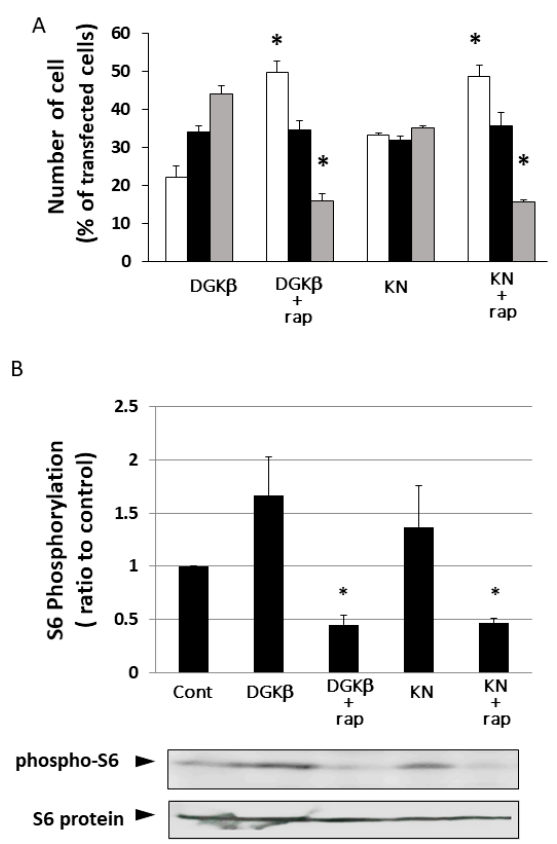
Figure 6. Involvement of mTORC1 in kinase-dependent and independent pathways for DGK β -induced neurite outgrowth. ( A ) Effects of rapamycin on the DGK β or DGK β KN-induced neurite outgrowth. The plasmid of GFP-DGK β or GFP-DGK β KN was transfected into SHSY-5Y cells. After 24 h, 1 μ M rapamycin was added and further cultured for 24 h. After fixed, more than 100 cells were observed in each experiment and three independent experiments were performed. White, black and gray columns show percentage of the number of cells having no, one or two and several neurites, respectively. The mean and SEM of number of the cells are shown as percentage to the transfected cells. * p < 0.05, followed by Student’s t -test (vs. the cells expressing GFP-DGK β or GFP-DGK β KN respectively). ( B ) Phosphorylation level of S6 protein. SH-SY5Y cells overexpressing GFP-DGK β or GFP-DGK β KN were cultured for 24 h, and then the cells were treated with 1 μ M rapamycin for 24 h. The lysates from these cells were applied to immunoblotting and detected with phosho-S6 and S6 antibodies (bottom blots). Quantification analysis of S6 phosphorylation level. Ratios of phosphorylation to total protein were normalized by the ratio in the control ( n = 3). * p < 0.05, followed by Student’s t -test (vs. control).